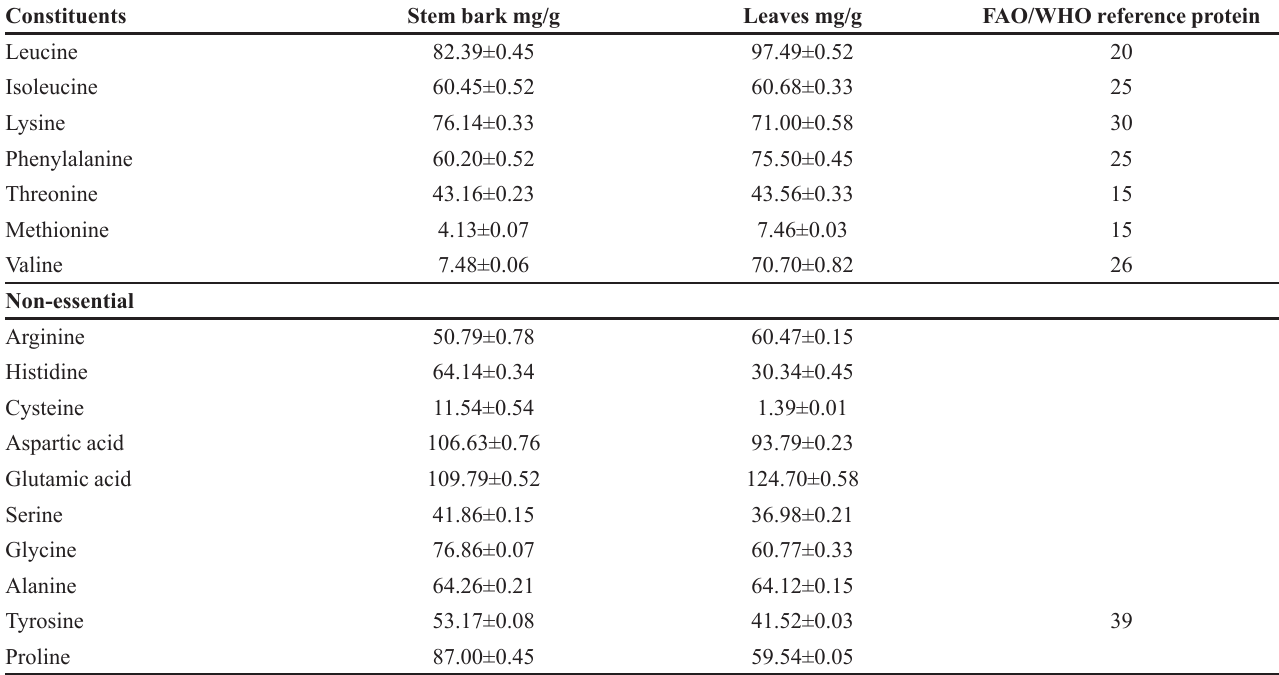
TABLE IV - Amino acid composition from leaves and stem bark extracts of A. laurina as compared to the FAO/WHO/UNU reference pattern (mg/g